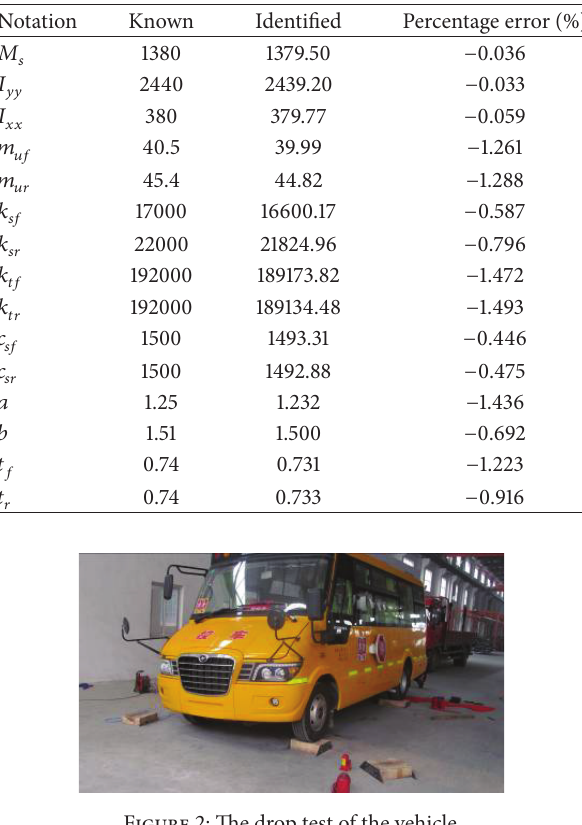
Figure 2: The drop test of the vehicle.